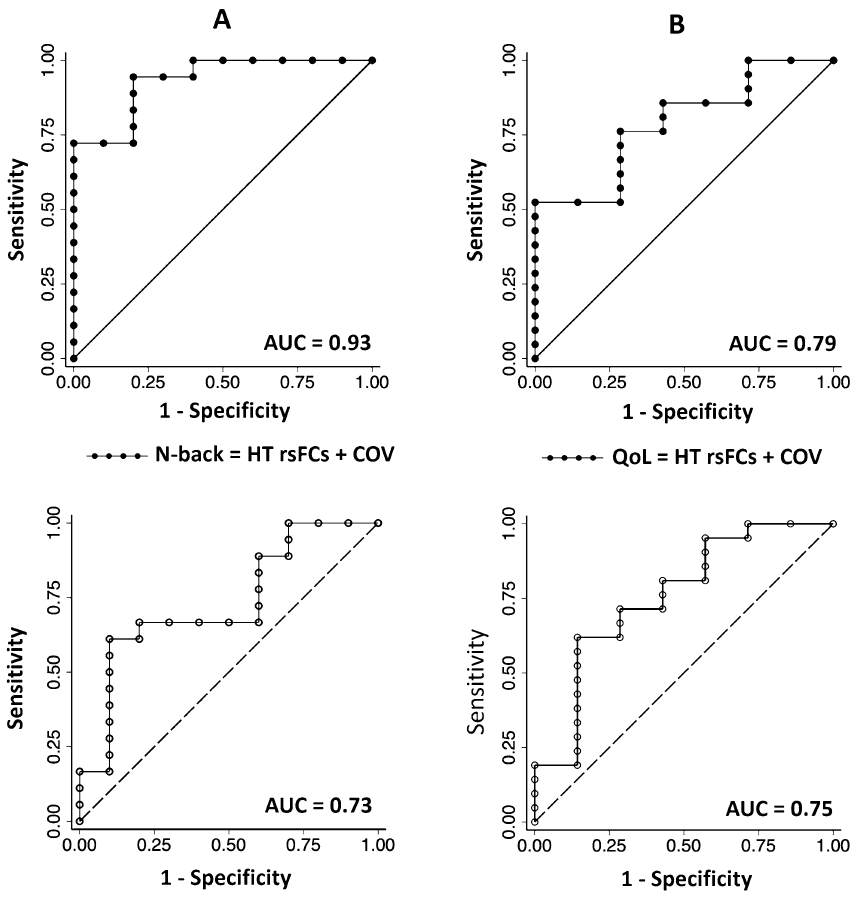
Figure 4. Receiver operating characteristic (ROC) analysis showing the accuracy (area under the curve, AUC) of baseline hypothalamus (HT) rsFC and covariates (solid line and circles) and covariates alone (dashed lines and open circles) in predicting overall changes (follow-up vs. baseline) in ( A ) N-back metrics (as revealed in latent class analysis) and ( B ) QoL score (total QoL score). Covariates (COV) included baseline age, education, and MoCA